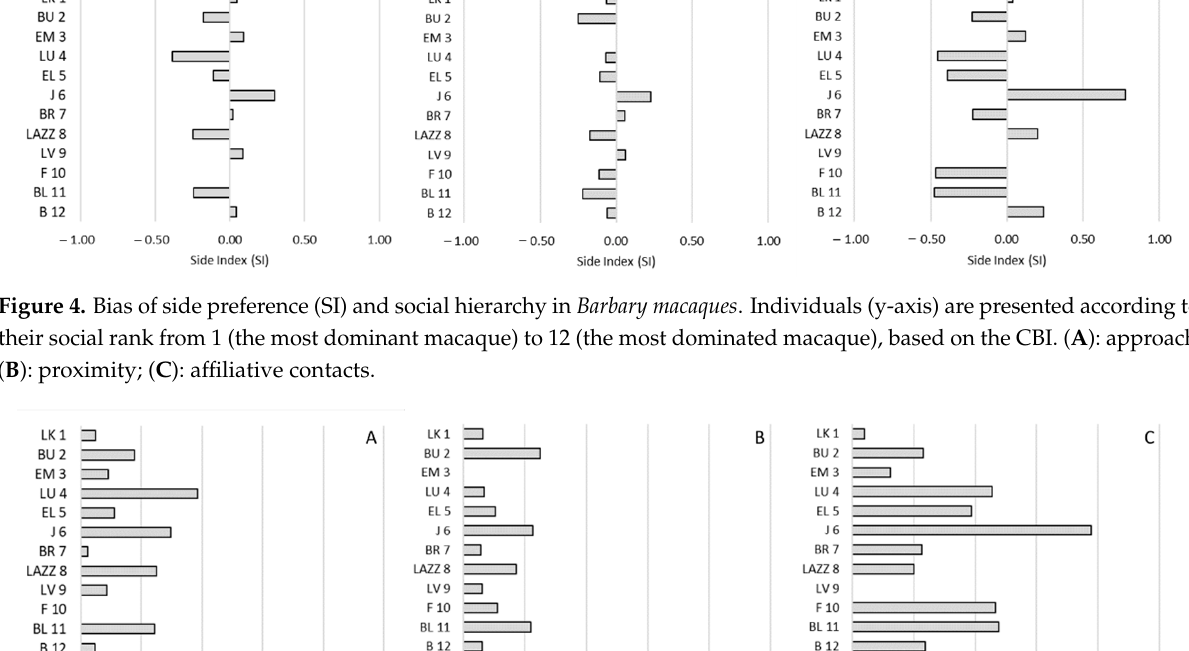
Figure 6. Bias of transversality preference (TI) and social hierarchy in Barbary macaques . Individuals (y-axis) are presented according to their social rank from 1 (the most dominant macaque) to 12 (the most dominated macaque), based on the CBI. ( A ): approach; ( B ): proximity; ( C ): affiliative contacts.